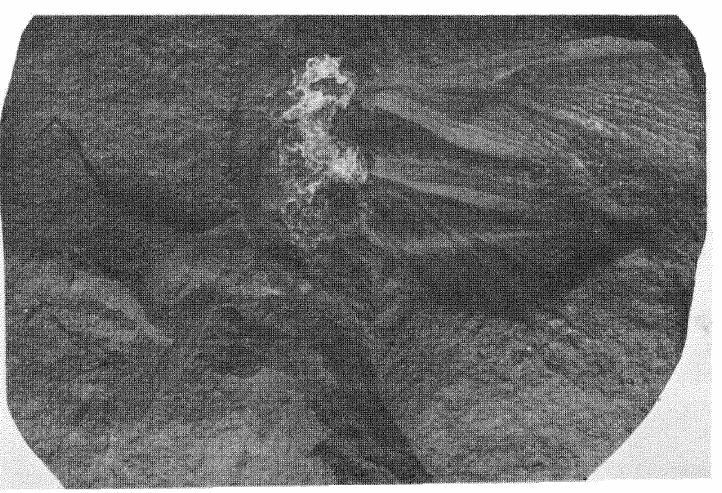
Fig. 27. Gerarulus radialis, photograph of holotype no. YPM 37. Length of fore wing 25 mm, as